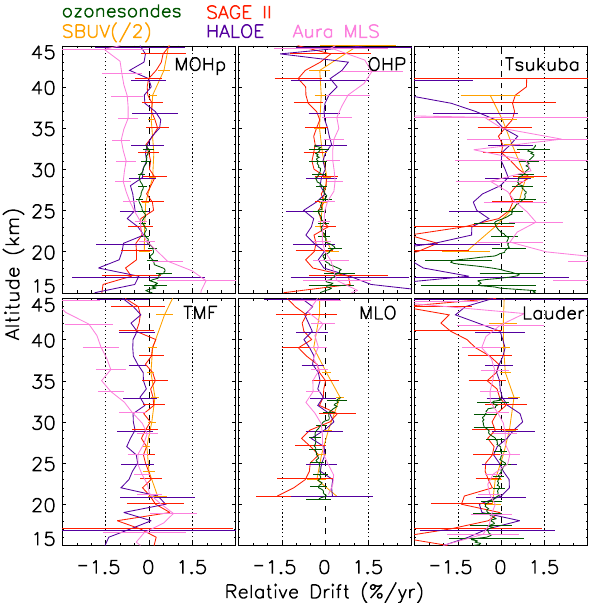
Fig. 4. Vertical distribution of the slopes evaluated from the monthly averaged difference time series of all observations with the lidar measurements at various regions bars represent twice the standard deviation of the slope. The dashed vertical line represents 0%yr − 1 , and the dotted vertical lines repre- sent ± 1.5%yr − 1 .